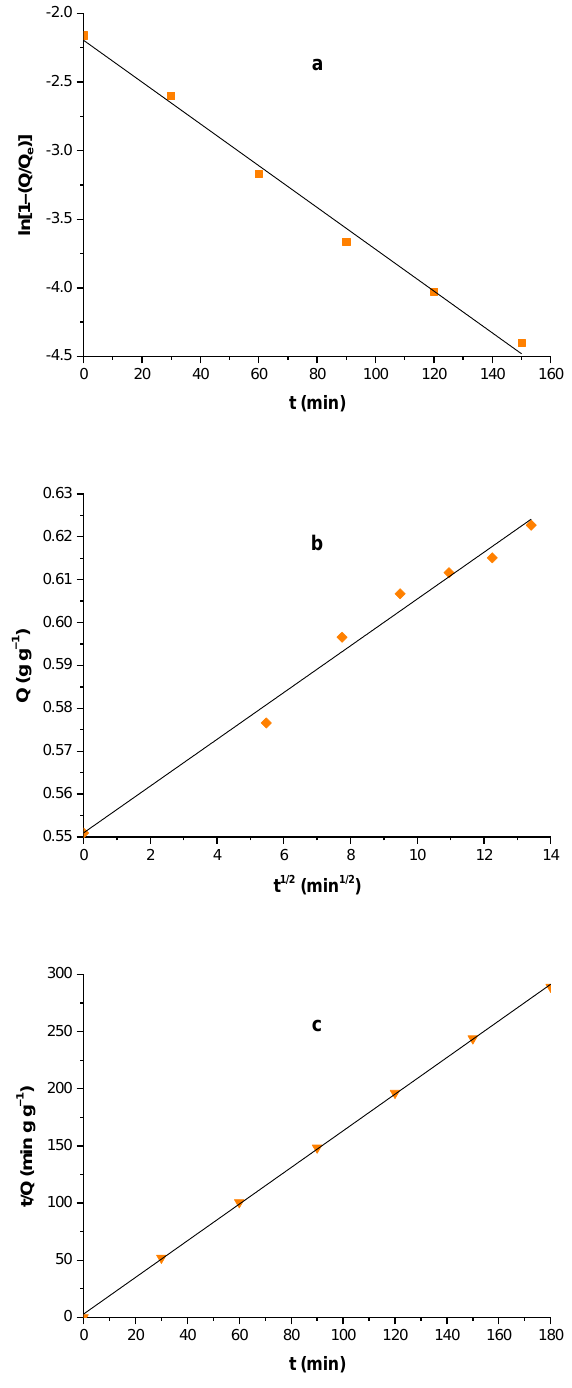
Figure 8. Kinetics of BB 3 adsorption on potassium humate at 323 K (pH = 4.0): ( a ) pseudo-first-order, ( b ) intraparticle diffusion, ( c ) pseudo-second-order.